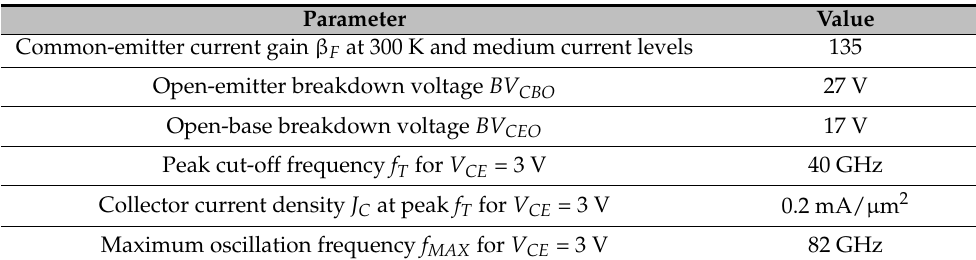
Table 3. Key features of the InGaP/GaAs NPN HBT under test.